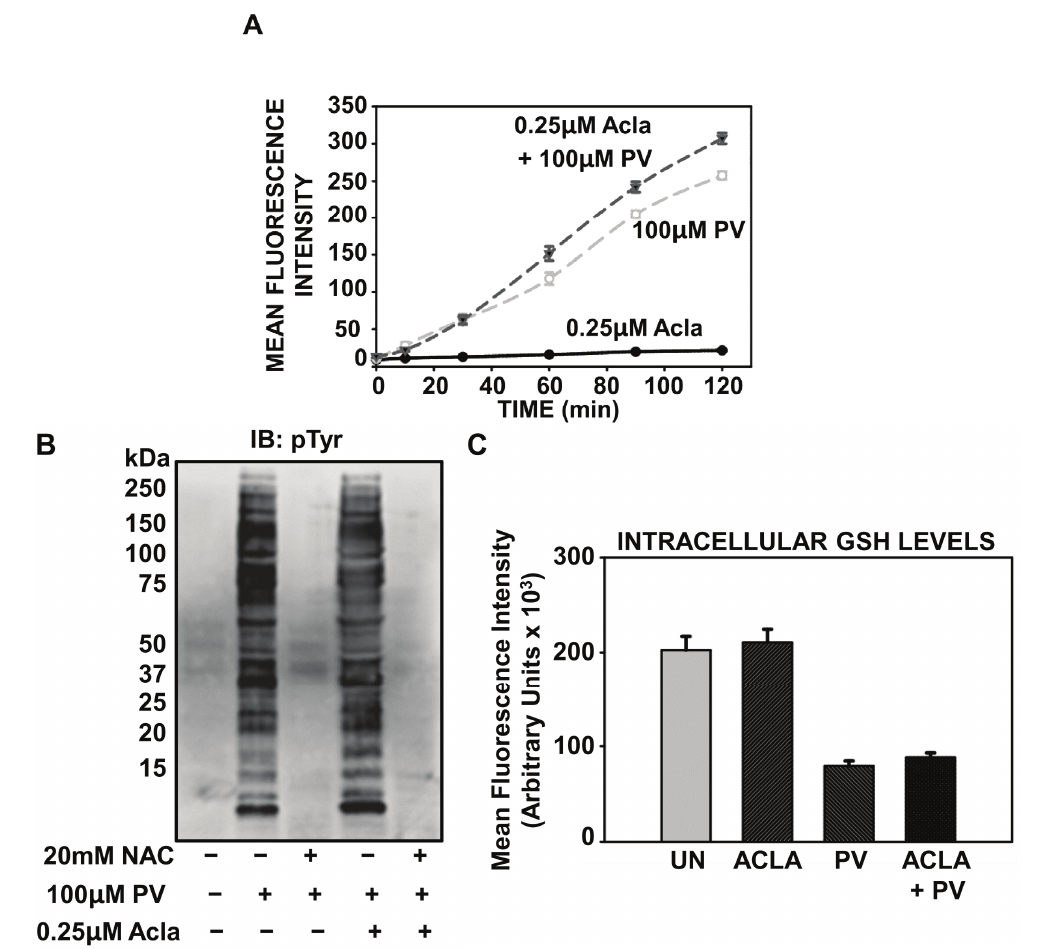
Figure 5. Proteasome inhibition potentiates oxidative stress associated with PV-stimulation. (A ) ILU-18 cells were either left untreated or treated with 0.25 μM Acla for 2 h. Following treatment with proteasome inhibitor, cells were washed and briefly incubated in 1X HBSS, prior to incubation with 10 (cid:4)M H 2 DCF-DA for 30 min at 37 °C in the dark. At the end of the incubation, cells were washed and resuspended in 1X HBSS. Intracellular oxidation was detected following addition of PV (100 μM), as described in the methods section. ( B ) ILU-18 cells were either left untreated or pretreated with 0.25 μM Acla for 2 h, in the presence or absence of 20 mM NAC. Media was then replaced and cells were selectively treated with PV (100 μM) for 20 min. At the end of incubation, cells were washed and cytosolic lysates prepared. Lysates, equalized for 30 (cid:4)g protein, were resolved using SDS-PAGE, followed by Western blotting using an antibody specific to Phospho-Tyrosine residues. Molecular weights derived from standards are indicated in kDa. ( C ) ILU-18 cells were treated with 100 μM pervanadate for 18 h, with or without pretreatment for 2 h with 0.25 μM Aclacinomycin. As controls, cells were either left untreated or subjected to treatment with 0.25 μM Aclacinomycin for 20 h. At the end of treatment, cells were lysed; 2 μL of MCB and GST were added to each sample and incubated at 37 °C for 15 min. Fluorescence was measured at an excitation wavelength of 340 nm and emission wavelength of 465 nm. Data obtained from duplicates of at least two independent experiments are presented; values represent mean fluorescence intensity (MFI) ± standard